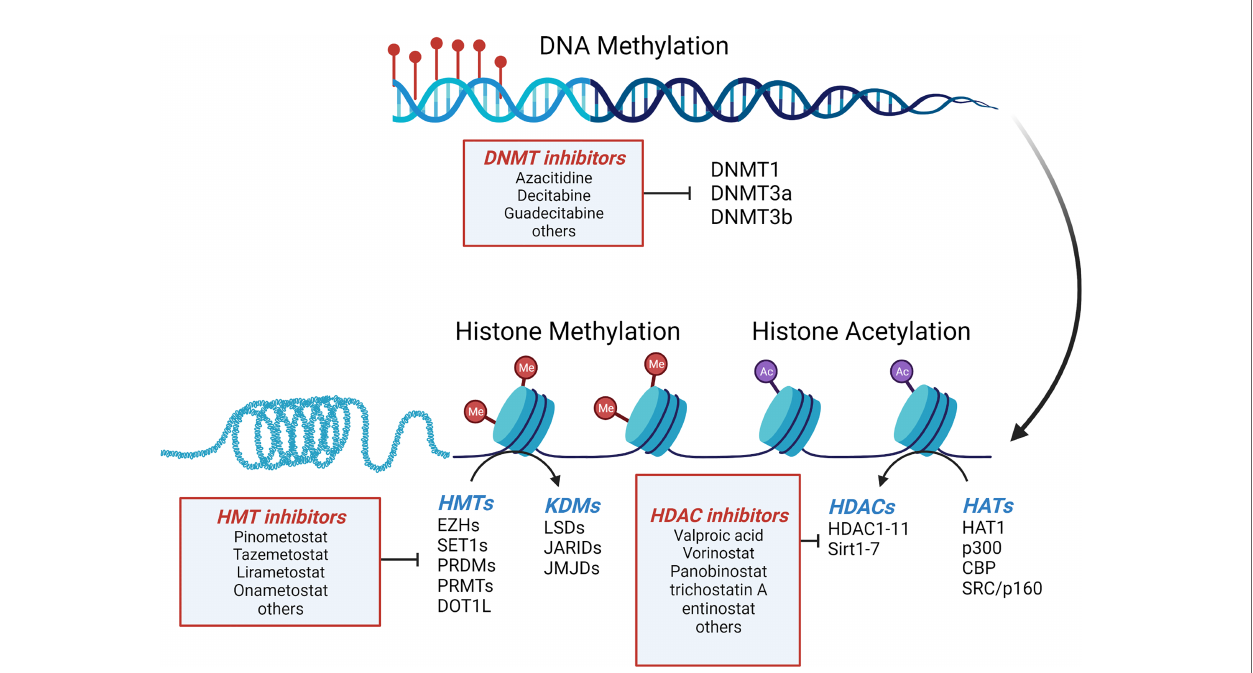
FIGURE 2 | Mechanisms of epigenetic regulation in GEP-NETs. Regulation of gene expression in GEP-NETs is controlled in part by DNA methylation, histone methylation and histone acetylation. Addition of methyl groups to cytosines in CpG islands of genes, along with hypermethylation and hypoacetylation of histones results in gene silencing. DNMT, DNA methyltransferases; HATs, histone acetyltransferases; HDAC, histone deacetylases; KDM, histone lysine demethylases; HMT, histone methyltransferases. Adapted from “ Epigenetic Levels ” by BioRender.com (2022), Retrieved from